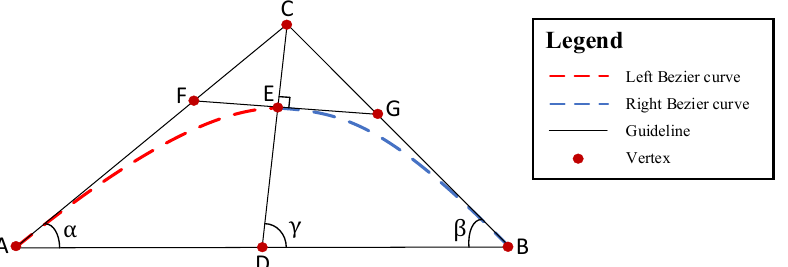
Figure 5. Diagrammatic sketch of reference stratum boundary generation.